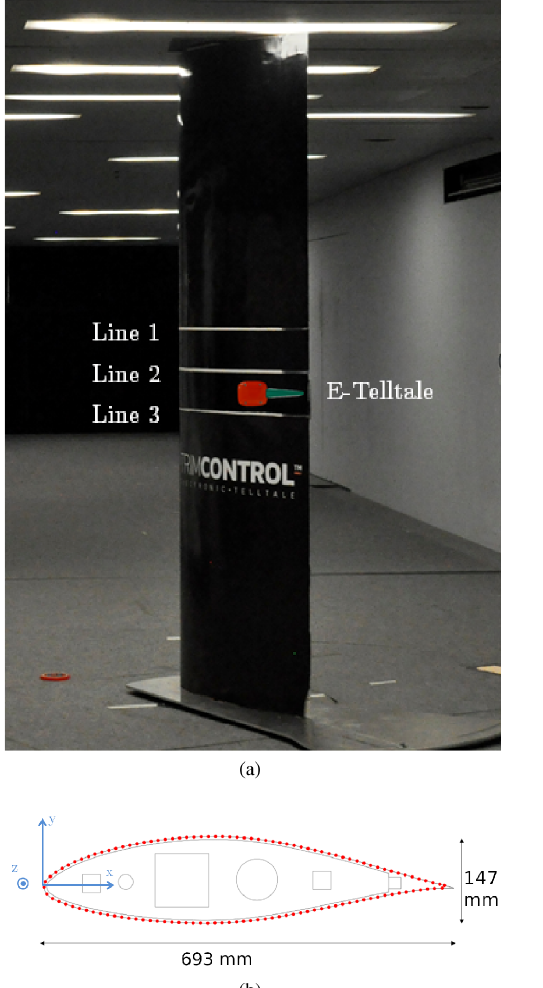
Figure 3. (a) Positions of the chordwise pressure lines along the span. (b) Positions of pressure taps around the